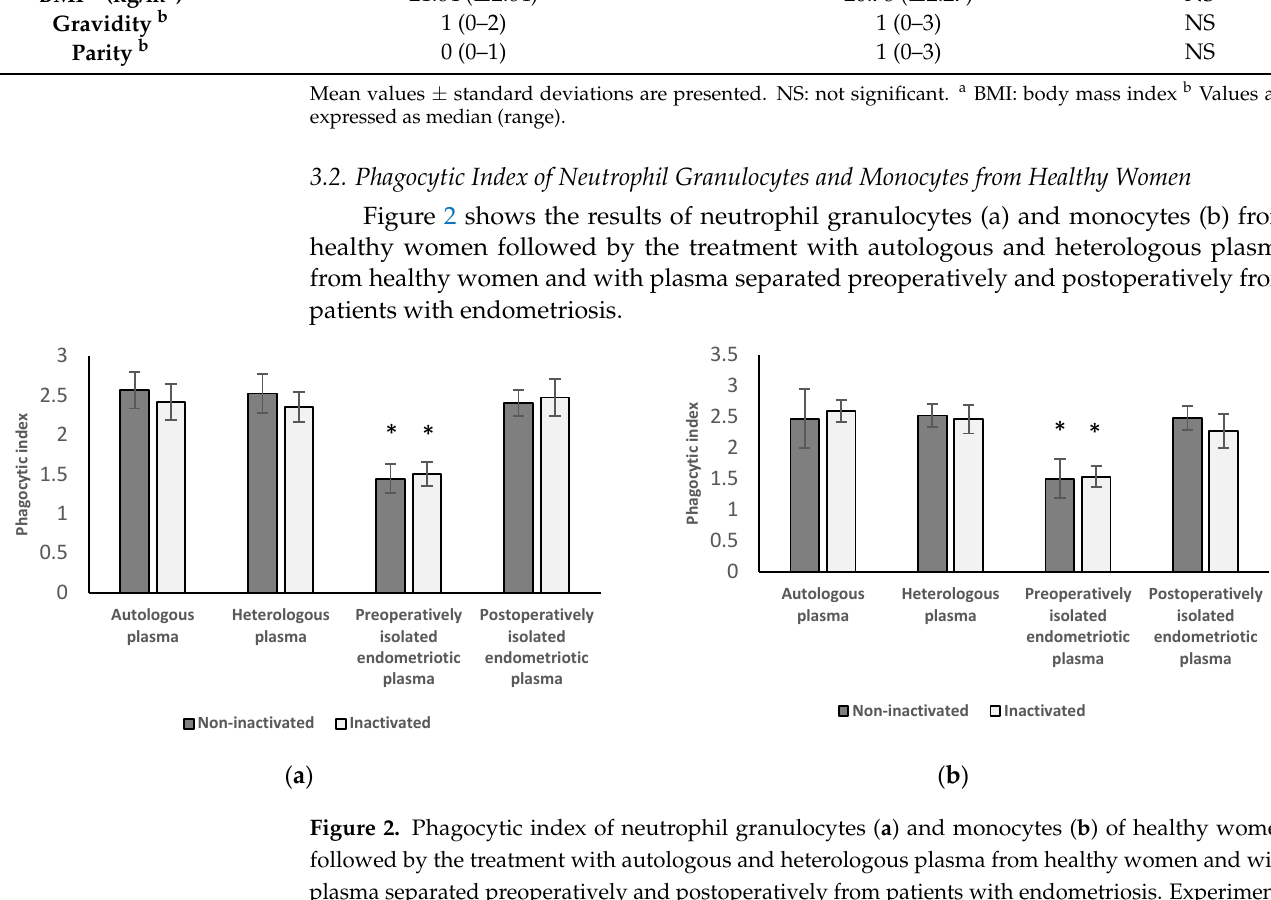
Figure 3. Phagocytic index of neutrophil granulocytes ( a ) and monocytes ( b ) of women with endo- metriosis before surgery followed by the treatment with autologous and heterologous plasma from the same group of patients and with plasma from women with endometriosis after surgery. Exper- iments were performed with inactivated and non-inactivated plasma samples in each group. * p < 0.001 compared with autologous and heterologous group.